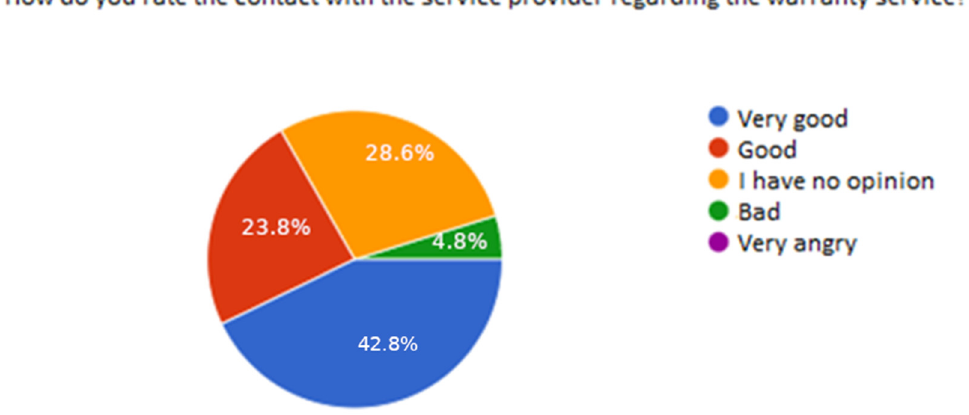
Figure 22. Warranty service.